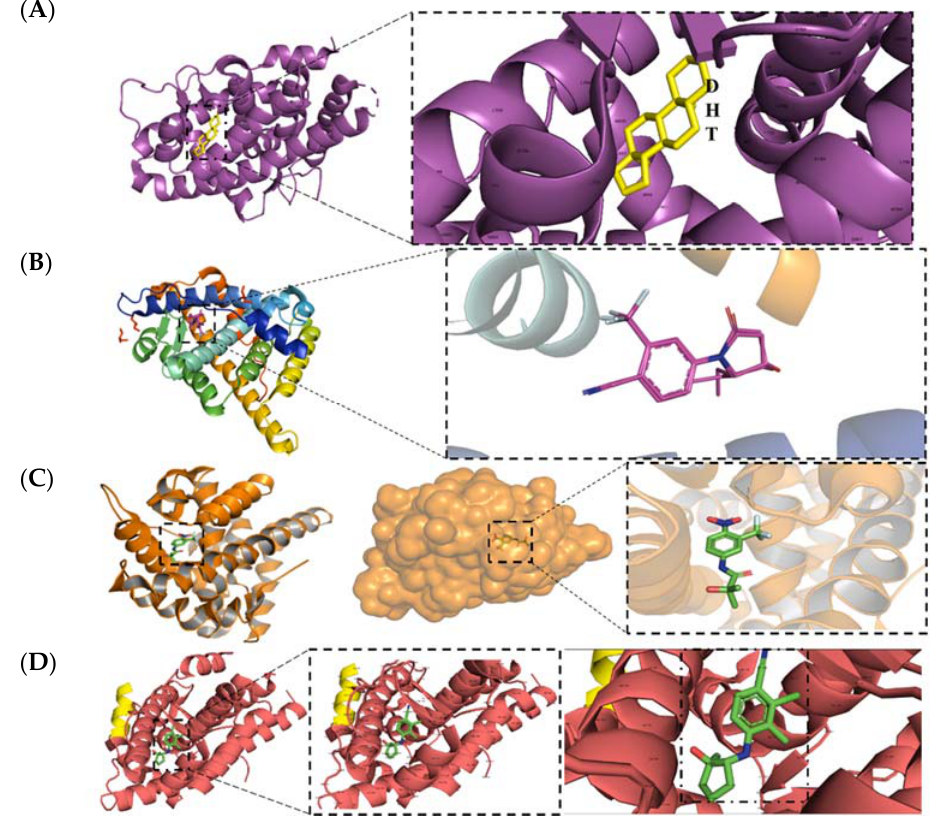
Figure 2. Conserved binding model for canonical ligands of the AR. Panel A : Cartoon model of a crystal structure of dihydrotestosterone (DHT) ( 2 ) bound to the ligand ‐ binding domain (LBD) (Protein Database (PDB) ID: 4OEA [23]). Panel B : Cartoon model of a crystal structure of a selective androgen receptor modulator (SARM) 13 (PDB ID: 5V8Q [24]. Panel C : Cartoon model of a crystal structure of hydroxyflutamide ( 10 ) bound to the T877A mutant AR LBD (PDB ID: 2AX6 [25]). Panel D : Cartoon model of a crystal structure of a SARM 14 bound to the LBD (PDB ID: 5CJ6 [26]).